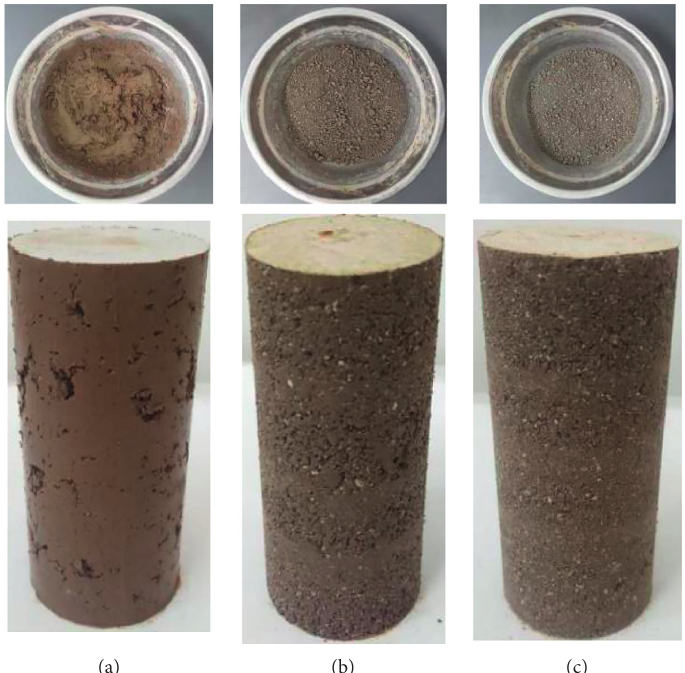
Figure 3: The triaxial mixture sample of different steel slag incorporation ( ω � 70%). (a) α